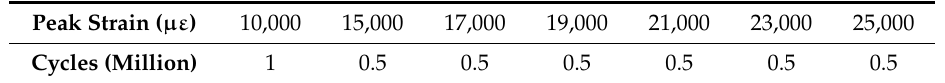
Table 3. Incremental loading sequence for each